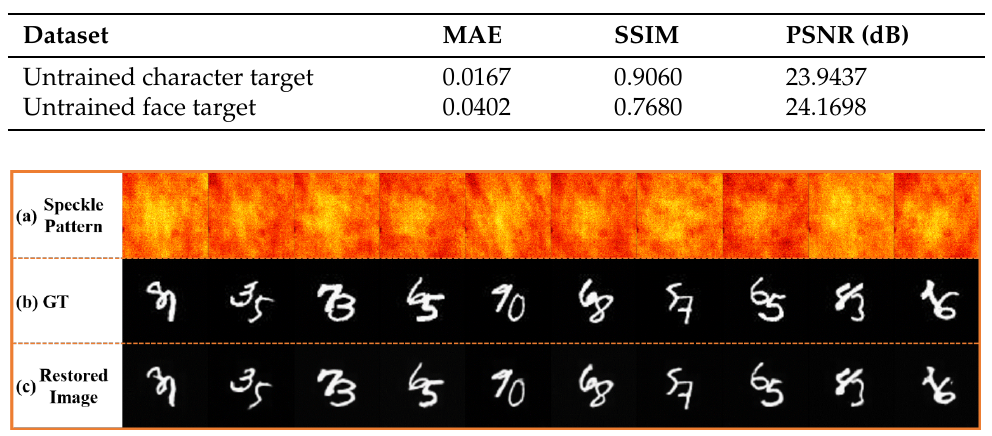
Table 1. Objective evaluation indexes of AESINet reconstruction results under test sets.